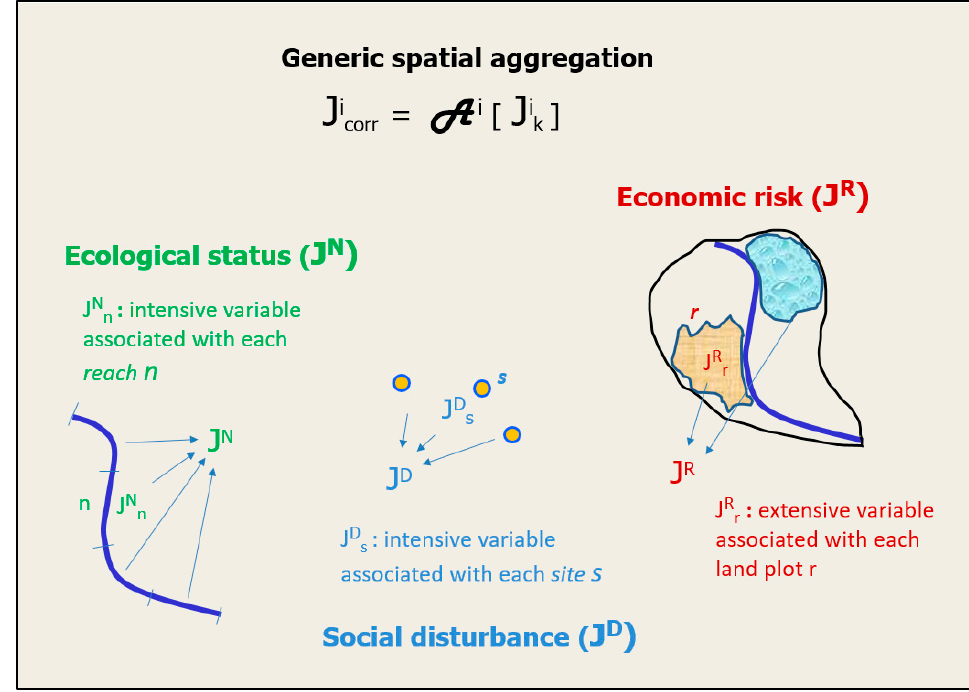
Figure 16. The generic i-th objective J i is the result of a spatial aggregation, according to a suitable operator A i [ • ]. Different spatial units (“pieces”) may be involved: river reaches (k = n), in the case of the ecosystem quality objective N J N = A N [J nN ]; several land units (land plots r: k = r) of a territory, in the case of the Risk objective R J R = A R [J rR ]; some sites (k = s) in the case of the Disturb- ance objective D J D = A D [J sD ] (e.g., hydropower generation loss in some plants; or loss of agricultural production in given properties). Depending on the formulation of the objective, the involved varia- bles can be extensive (depending on the areas in the case of economic component of risk J rR ; or the numerosity of affected hydropower plants), or intensive (e.g., ecosystem quality, in the case of J nN ).